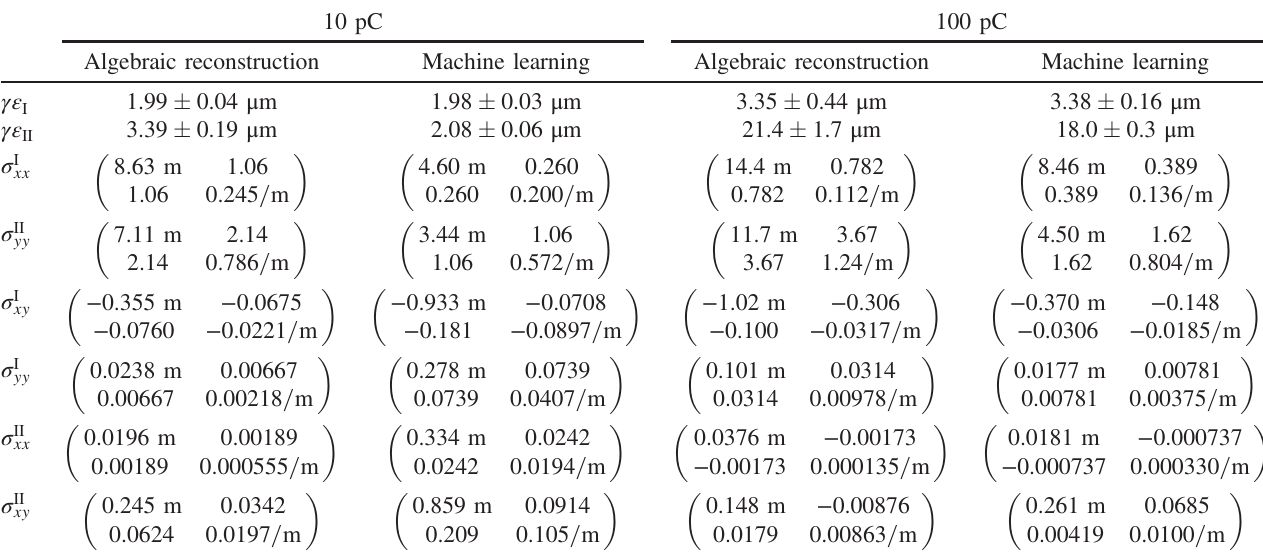
TABLE II. Emittances and lattice functions describing the 4D phase space distributions obtained by phase space tomography in CLARA. The values given refer to the normal modes [32]. In the absence of coupling, the elements of the matrices σ I xx and σ II yy are (respectively) β x and β y (top left elements) and − α x and − α y (top right elements); and all other matrices are zero. 10 pC 100 pC Algebraic reconstruction Machine learning Algebraic